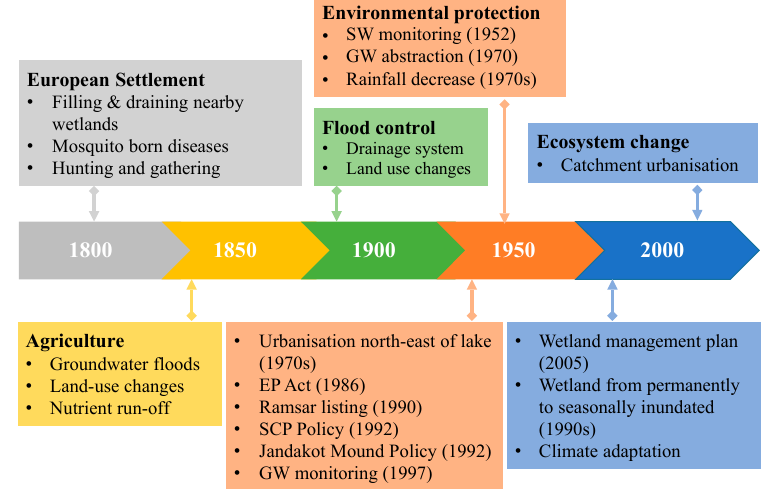
Figure 4. A historical representation of time and scale the traditional human-nature system and water resources system of Forrestdale Lake with indicated key events of the four subsystems: Natural resources, infrastructure, socio-economics and institution.